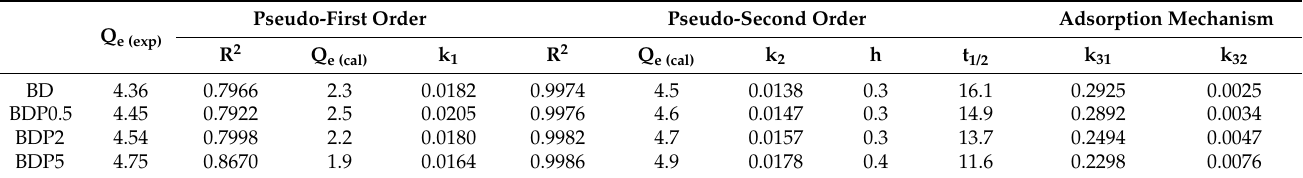
Table 3. Pseudo-second-order and pseudo-first-order kinetics parameters (conditions: 5 g/L of adsorbent dosage, 25 mg/L of initial concentration, pH of 8, and temperature at 303